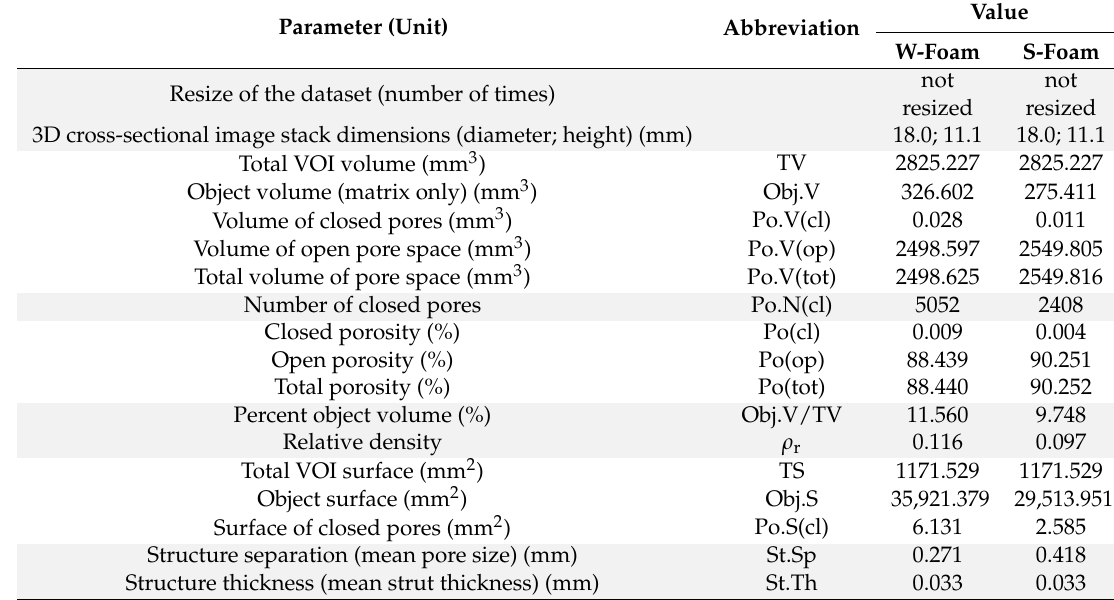
Table 8. The CTAn output morphometric parameters for W- and